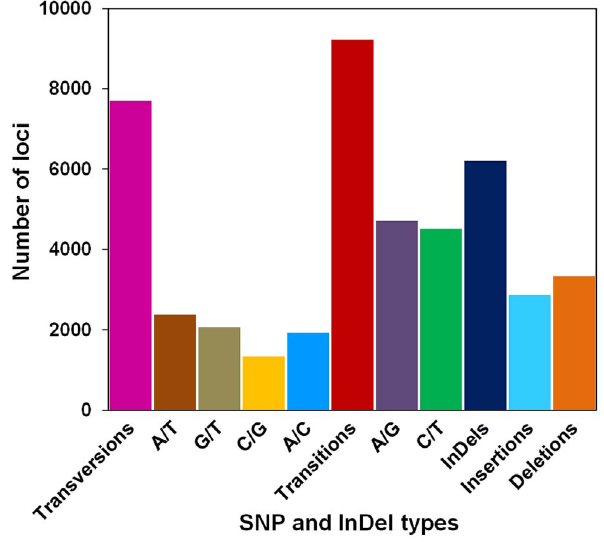
Figure 5. Distribution of putative single nucleotide polymor- phisms (SNPs) and insertions and deletions (InDels) in the yellow horn transcriptome.